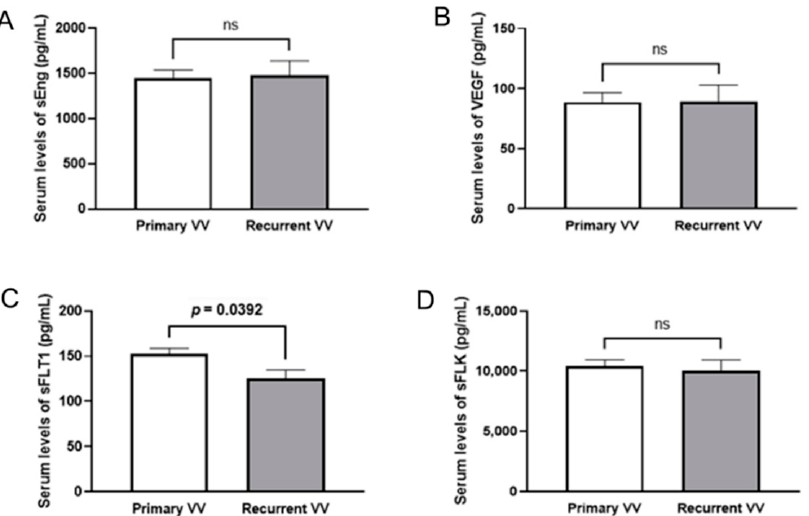
Figure 4. Serum levels of angiogenic or anti-angiogenic soluble factors. ( A – D ) Quantitative analysis of the concentration (pg/mL) of the molecules investigated in the serum of patients (obtained before surgery), sEng: soluble endoglin, ( A ), VEGFA: vascular endothelial growth factor A ( B ), sFLT1: soluble fms-like tyrosine kinase 1 (or VEGFR1) ( C ) and sFLK: soluble foetal liver kinase (or VEGFR2) ( D ) were analysed in both patients with primary varicose vein and patients with recurrent varicose vein. Mean ± SEM are displayed. The p -value obtained after t-test analysis indicated if it is statistically significant. ns: not significant. Table 3. Serum levels (pg/mL) of the molecules investigated. Primary Varicose Veins Recurrent Varicose Veins